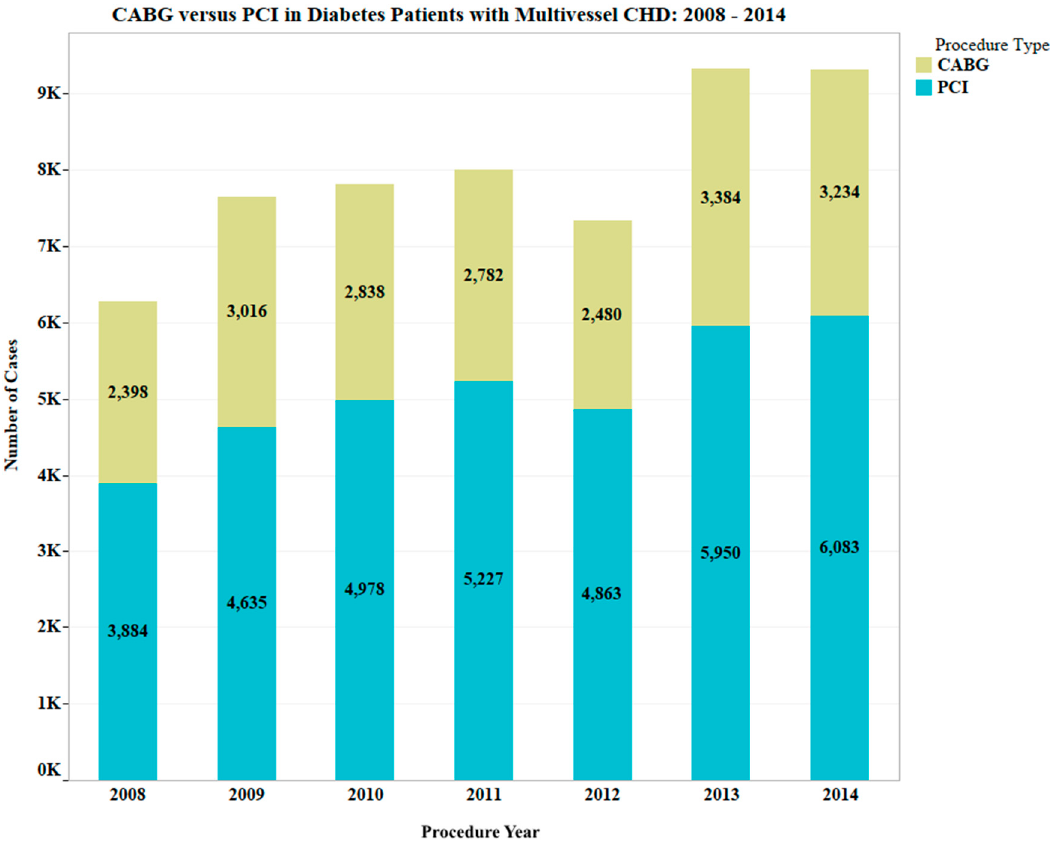
Figure 1. CABG versus PCI in diabetic patients with multivessel coronary heart disease (CHD) from 2008–2014. The graph includes patients from 2012 for comparison on an annual basis. As mentioned, this study did not include data from 2012 in the analysis and does not show patients analyzed in 2015.